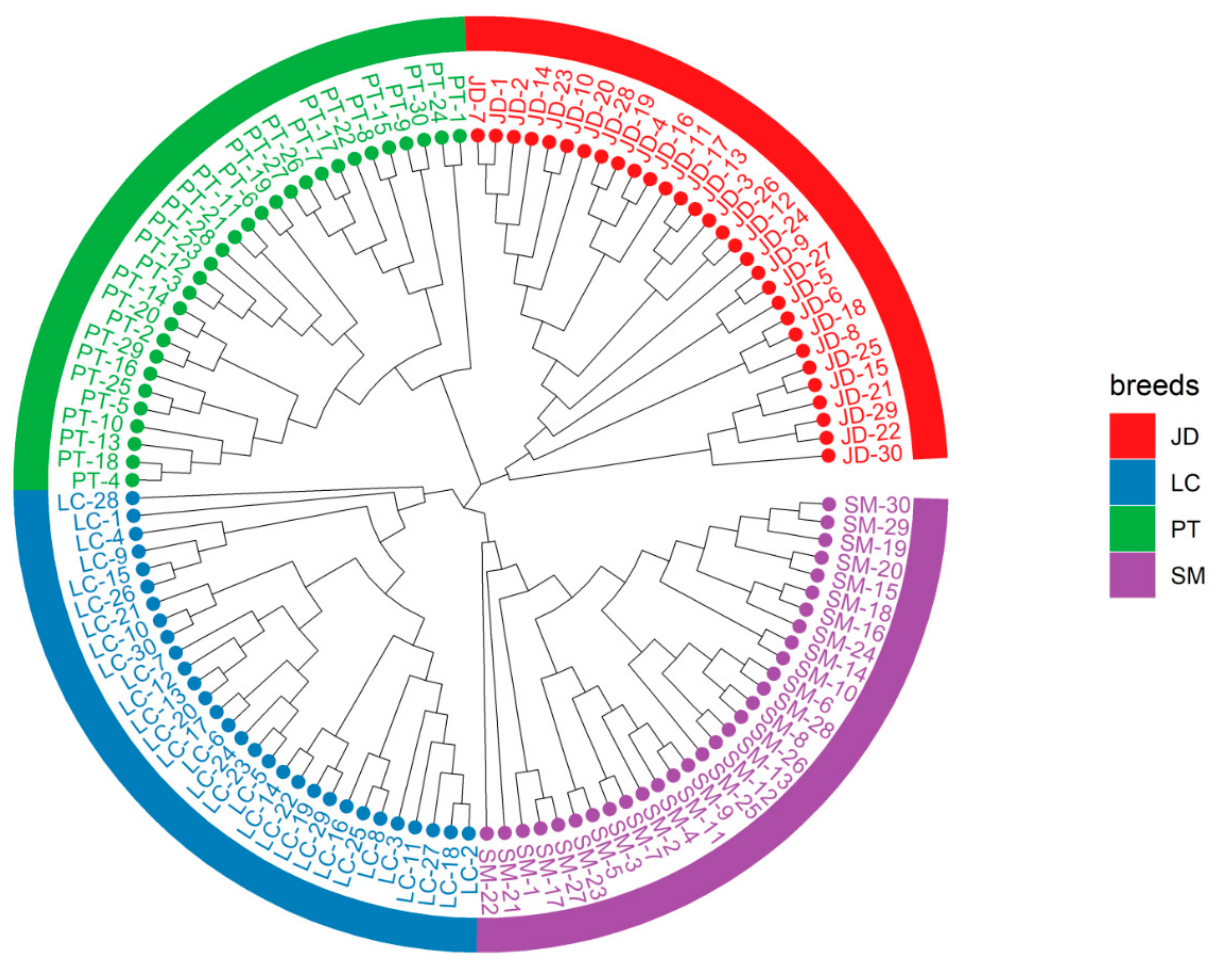
Figure 3. Phylogenetic trees showing the genetic structure of the 120 indigenous ducks individuals.